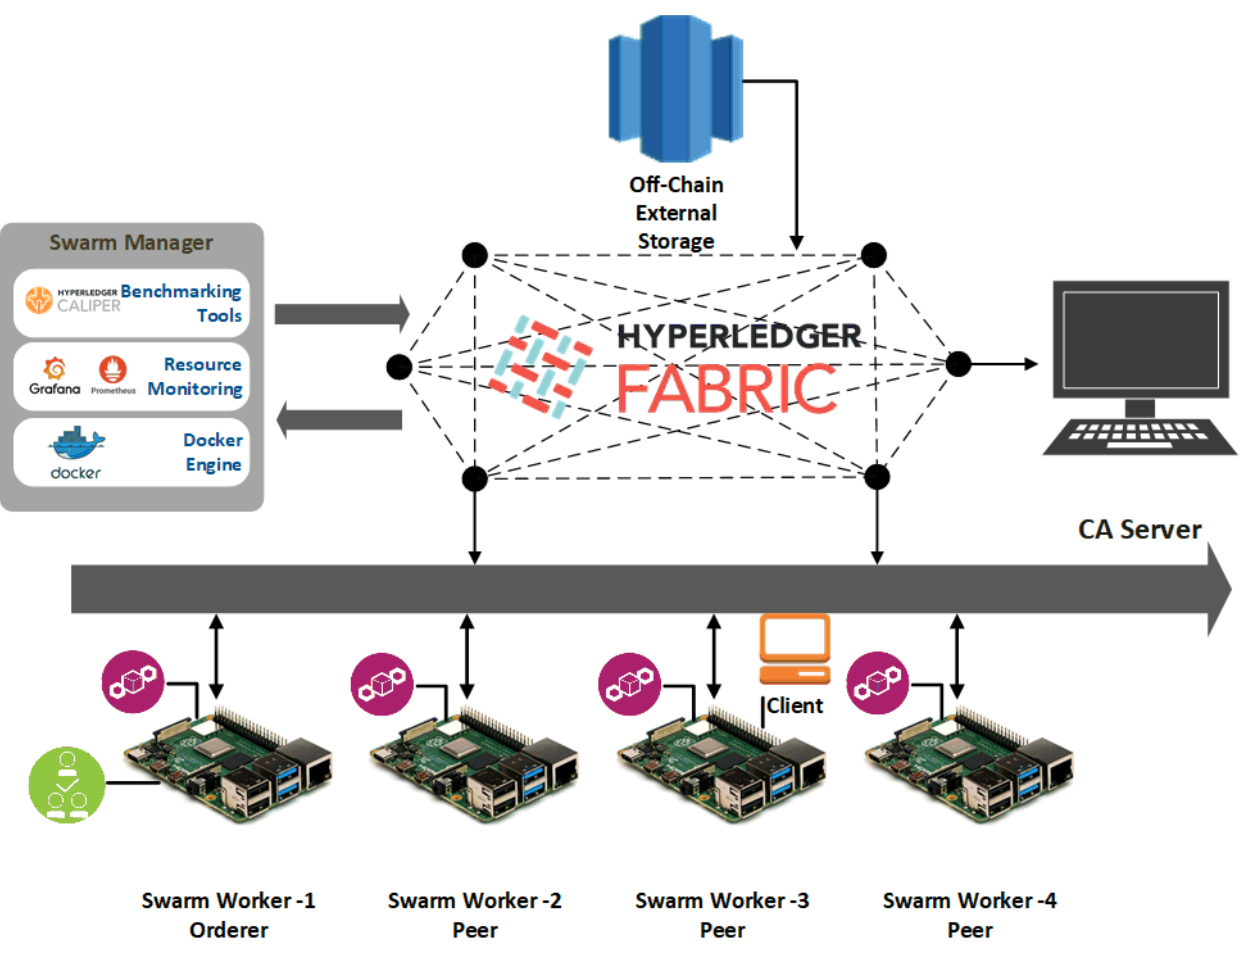
Figure 7. Experimental setup and system under